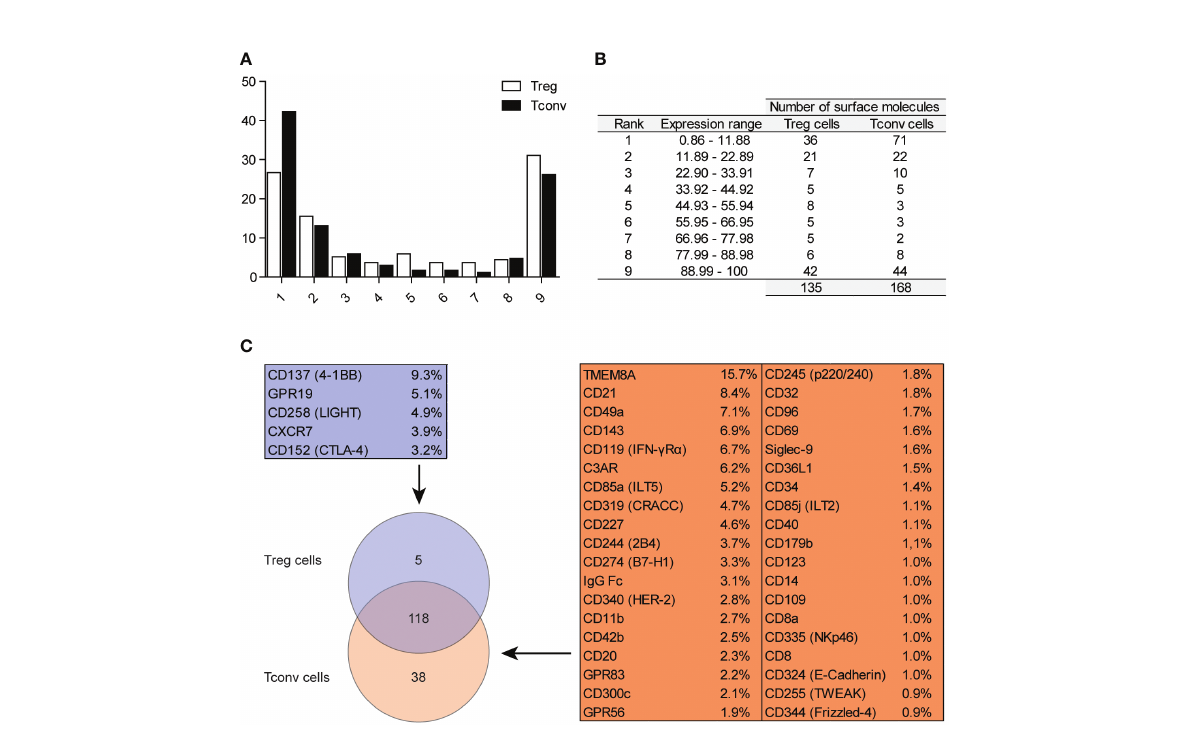
FIGURE 1 Classi fi cation of surface markers on Tconv and Treg cells. (A) Graphical presentation of frequency distribution of surface markers on Treg (n=5) and Tconv cells (n=5). (B) Tabular presentation of classi fi cation of surface markers based on their expression on Treg (n=5) and Tconv (n=5). (C) Venn diagram showing the identi fi cation of surface markers exclusively expressed on Treg or Tconv cells. Data are presented as mean (n=5, for both Treg and